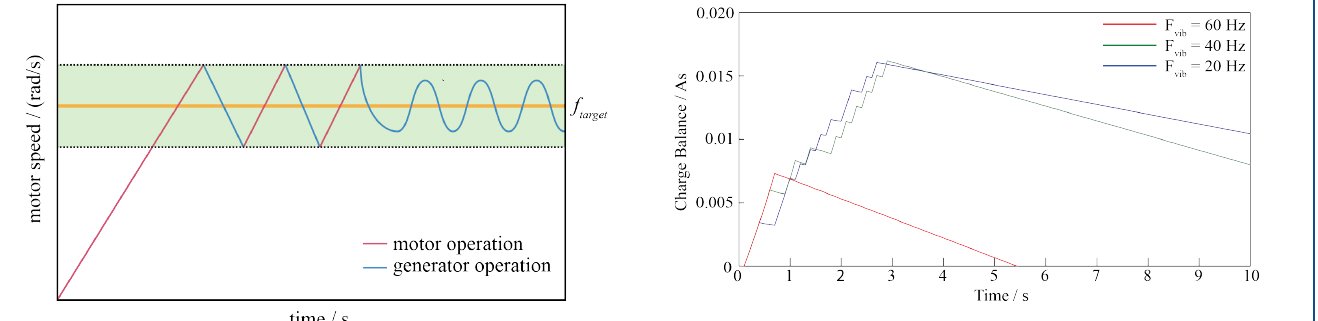
Table 1. Generator output power over Frequency